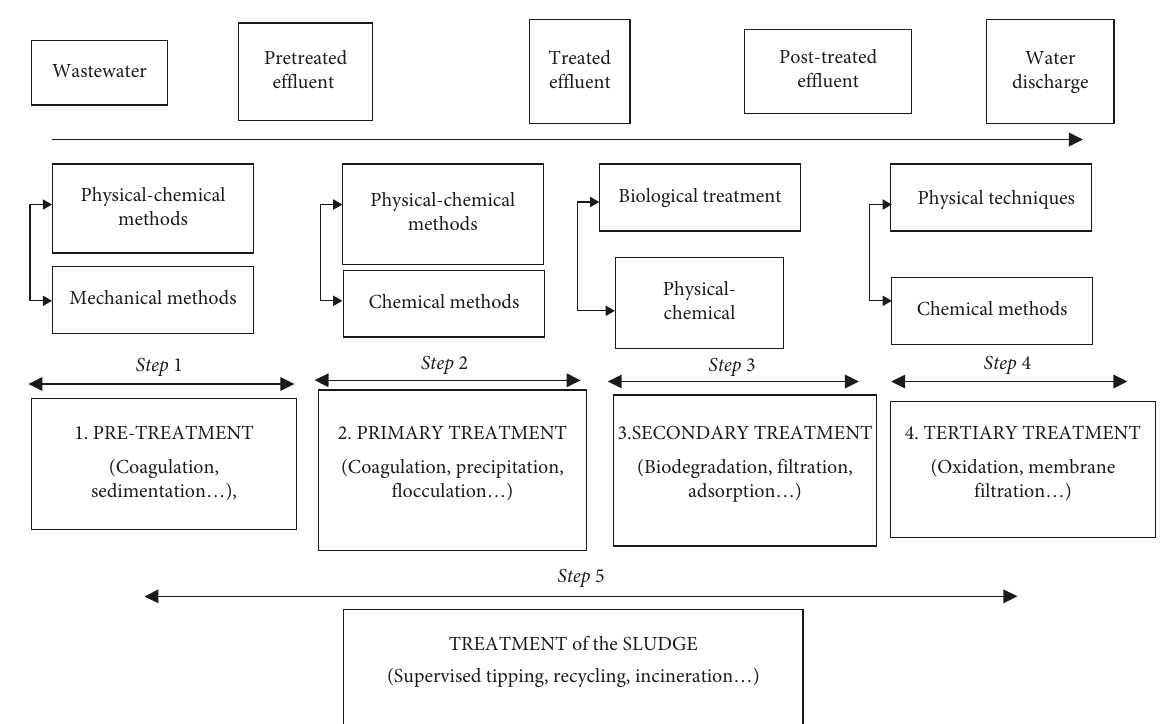
Figure 1: Summary of wastewater treatment processes (adopted from